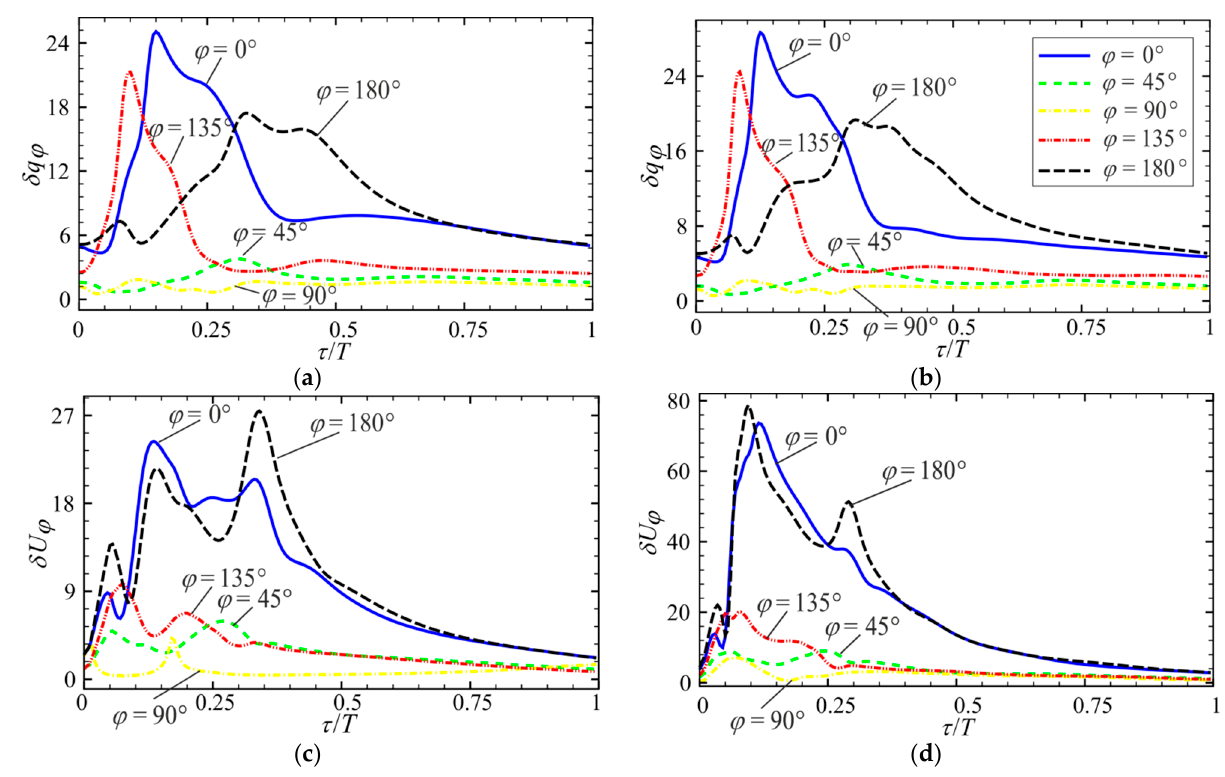
Figure 13. The effect of pulsations on the instantaneous local heat flux and velocity at f = 0.5 Hz for one period of pulsation. ( a ) Variation of heat flux ratio δ q φ = q φ , p / q φ , st with τ / T at A / D = 1.25. ( b ) Variation of δ q φ with τ / T at A / D = 4.5. ( c ) Variation of velocity ratio δ U φ = U φ ,, p / U φ ,, st with τ / T at A / D = 1.25. ( d ) Variation of δ U φ with τ / T at A / D = 4.5.